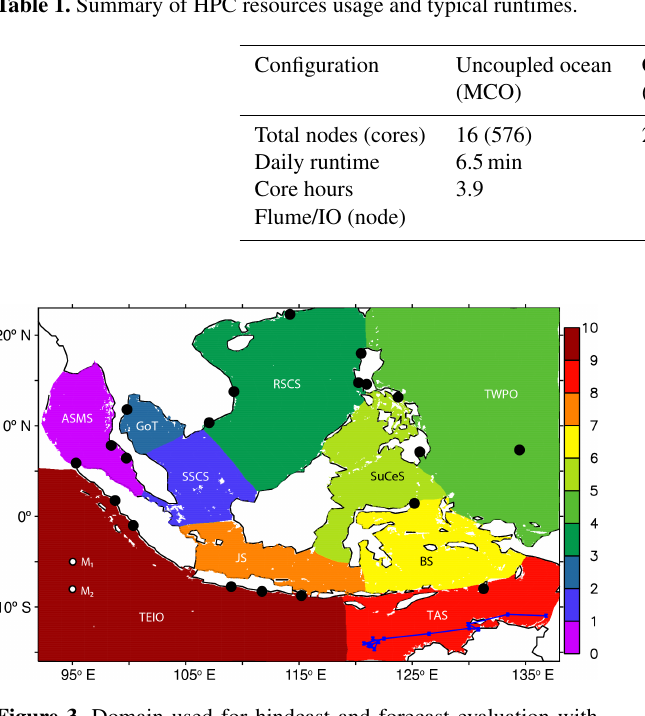
Model hindcasts and forecasts over the region 16 ◦ S to 23 ◦ N and 92 to 138 ◦ E and defined as the analysis domain (Figs. 1 and 3), is further used for the analysis. The MC model domain includes oceanic basins with different geo- graphical and climatological characteristics. For the evalu- ation purpose, we have divided the analysis-domain into 10 sub-regions based on their geographical distribution (Fig. 3).